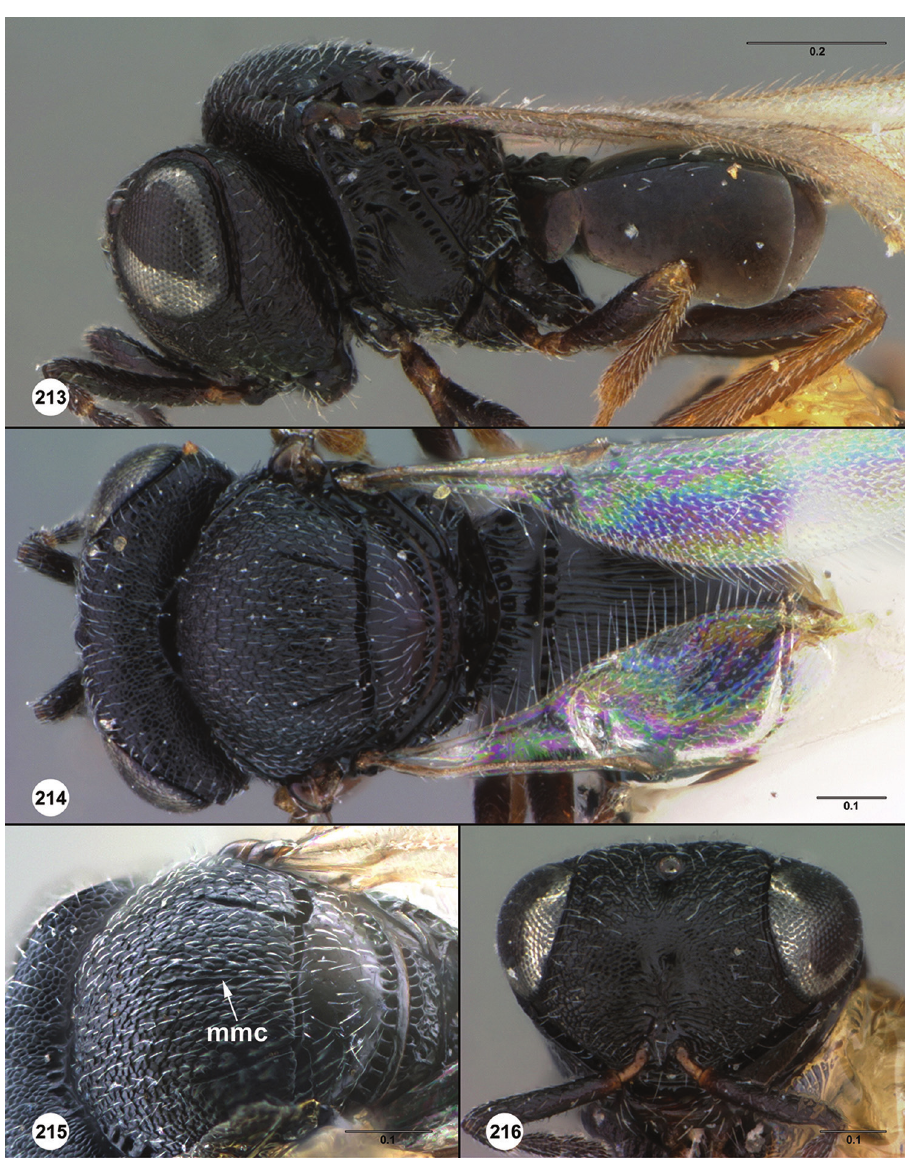
Figures 213–216. Trissolcus viktorovi 213 female paratype (USNMENT00916021), head, mesosoma, metasoma, lateral view 214 female paratype (USNMENT00916647), head, mesosoma, metasoma, dorsal view 215 female paratype (USNMENT00916010), mesosoma, dorsal view 216 female paratype (USN- MENT00916014), head, anterior view. Scale bars in millimeters. carina: present only posterior to lateral ocellus. Macrosculpture of posterior vertex: absent. Microsculpture on posterior vertex along occipital carina: present. Anterior margin of occipital carina: coarsely